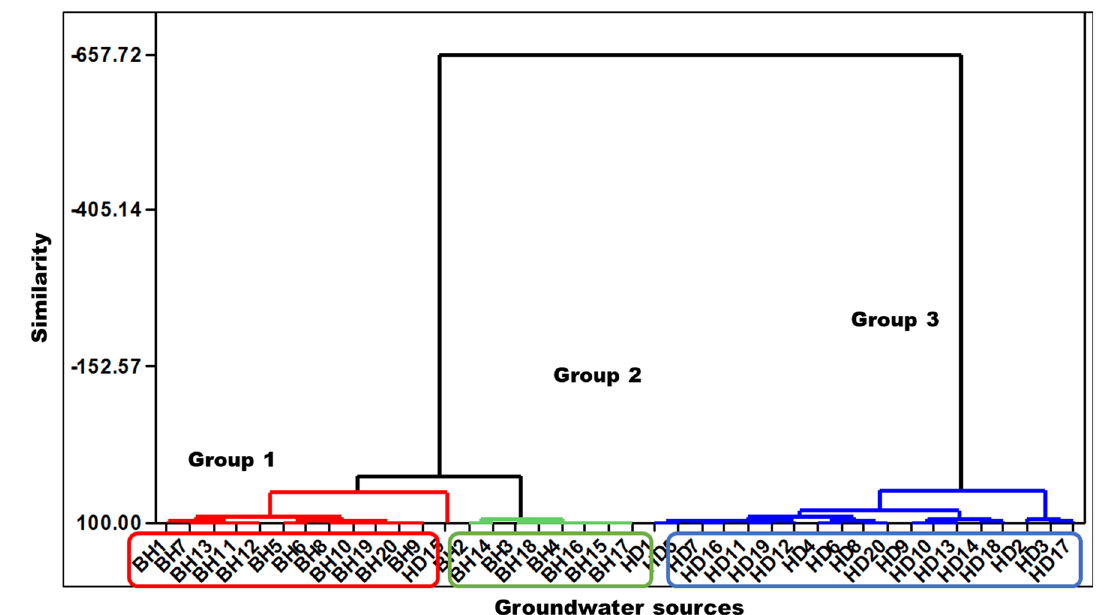
Fig. 11 Dendrogram produced from cluster analysis based on sam- pling boreholes to understand the most important hydrochemical physiognomies in Basement Complex areas of southern Kebbi State. Three groups were distinguished viz. Group 1 (BH1, BH7, BH11, BH12, BH5, BH6, BH8, BH10, BH19, BH20, BH9 and HD15),